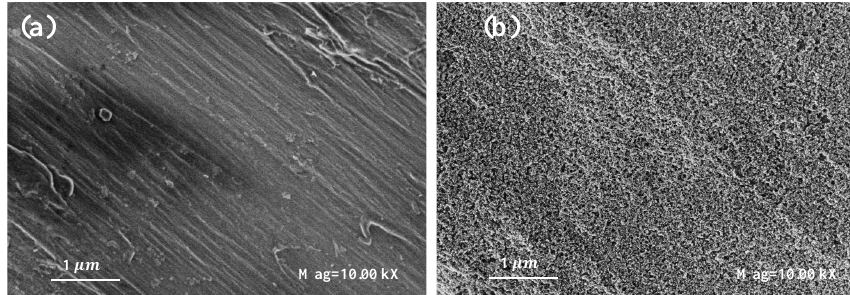
Figure 3. SEM images of cotton fabric: ( a ) untreated sample; ( b ) Nano TiO 2 -coated